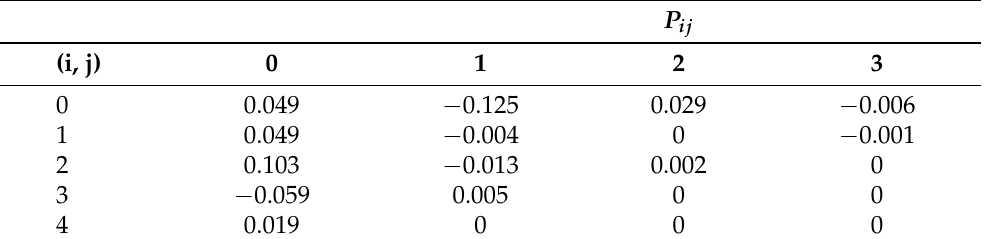
Table 2. Coefficients P ij for the K ∗ s .